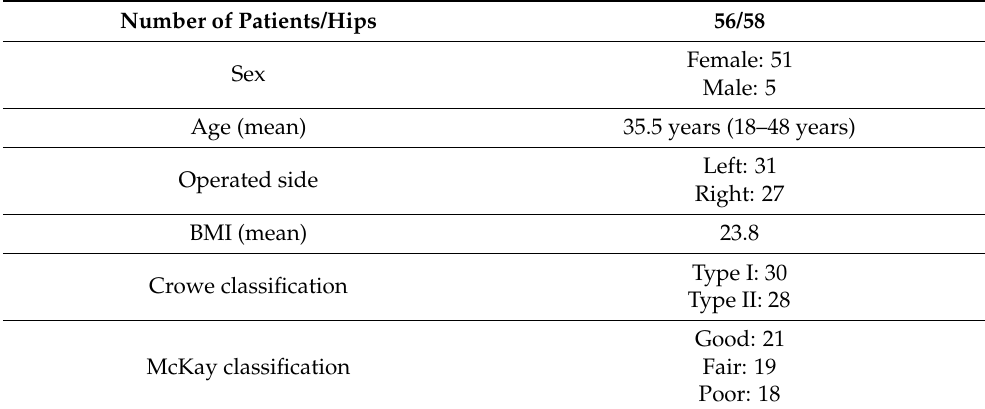
Table 1. Demographic data and classification according to Crowe and McKay.